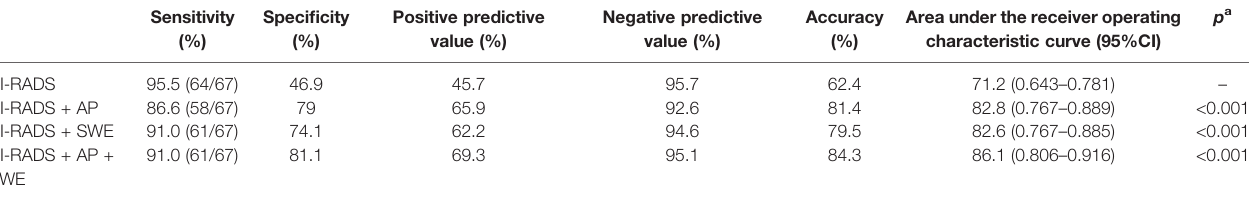
Data are expressed as percentage (numbers). a Comparison of the diagnostic performance between BI-RADS alone with the combination of the qualitative SWE and/or AP with